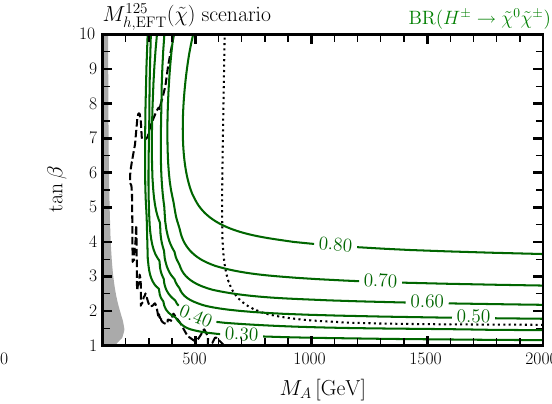
Fig. 8 Charged Higgs-boson phenomenology in the M 125 nario. Left : Production cross section (in fb) of a negatively charged Higgs boson H − in association with a top quark ( green contour lines ) at the LHC with 13TeV center-of-mass energy. Right : Branching ratio of the charged Higgs boson decaying into chargino–neutralino pairs